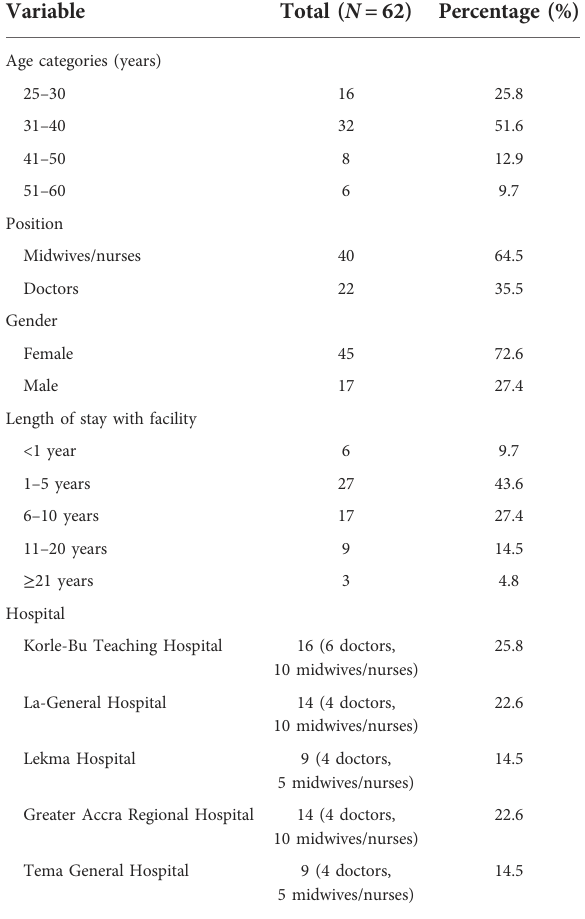
TABLE 1 Characteristics of study